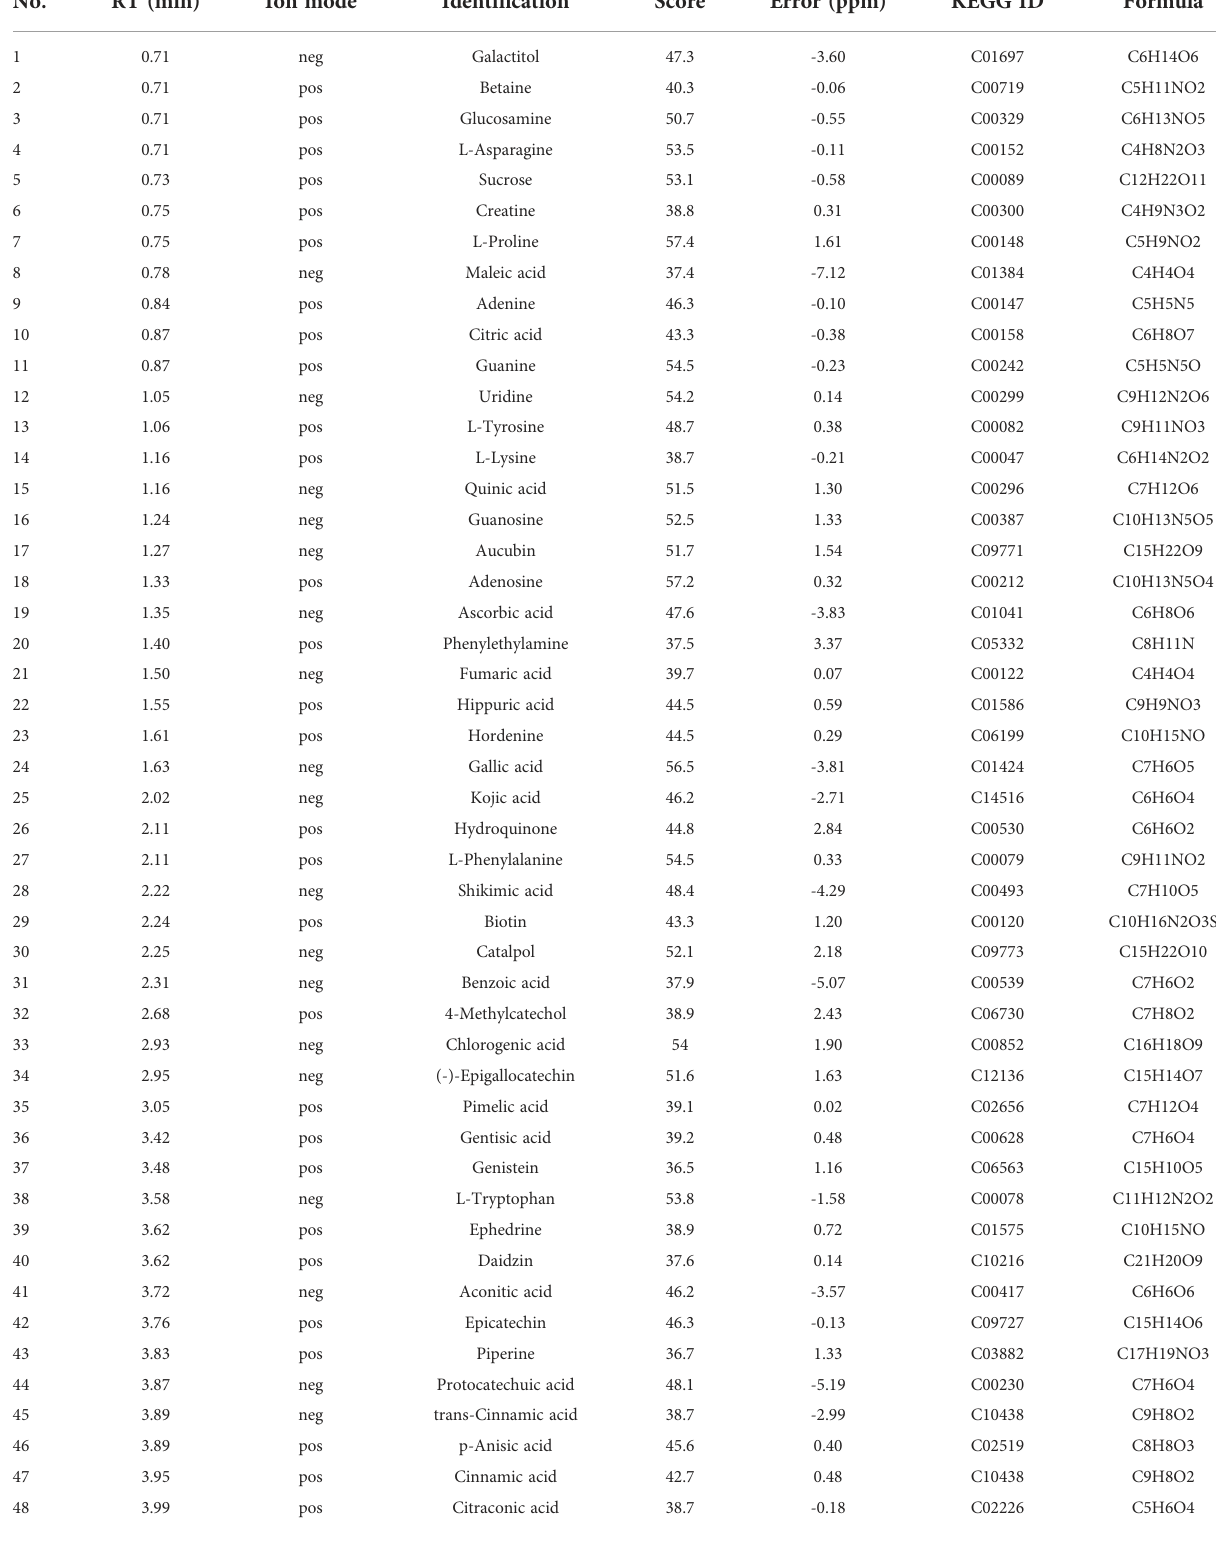
TABLE 2 Identi fi ed chemical compounds within YHT by